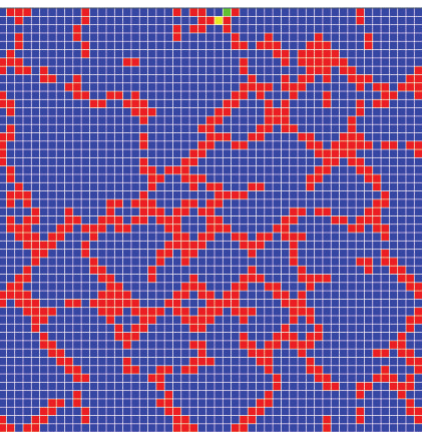
Figure 3: Simulation results on a 50 × 50 square lattice with von Neumann neighborhood and random initial distribution of